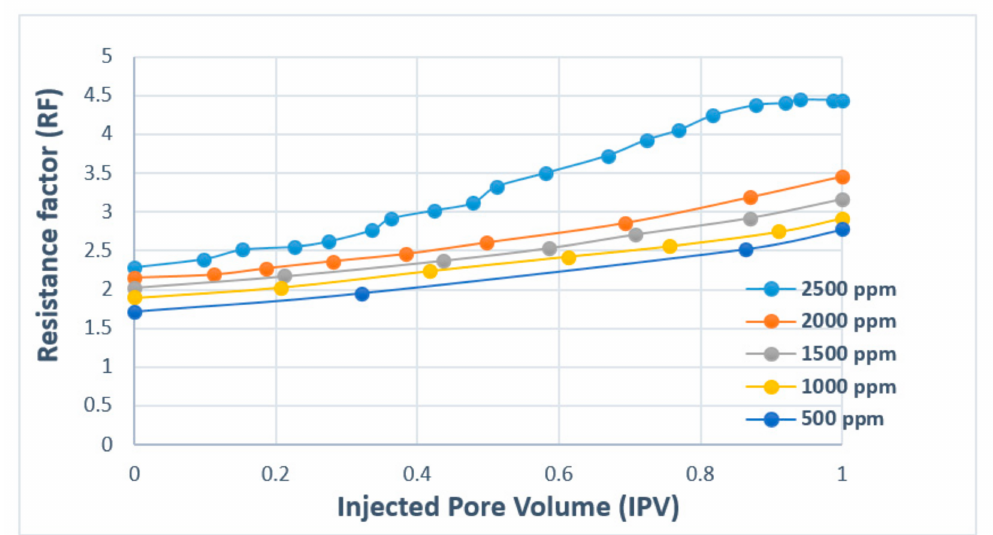
Figure 17. Resistance factor (RF) versus injected pore volume (PV) for HPAM. Reprinted and modified from [72].